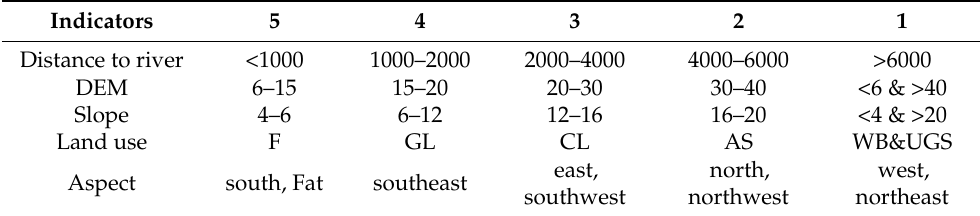
Table 4. Grading of the suitability evaluation indicators for forest.